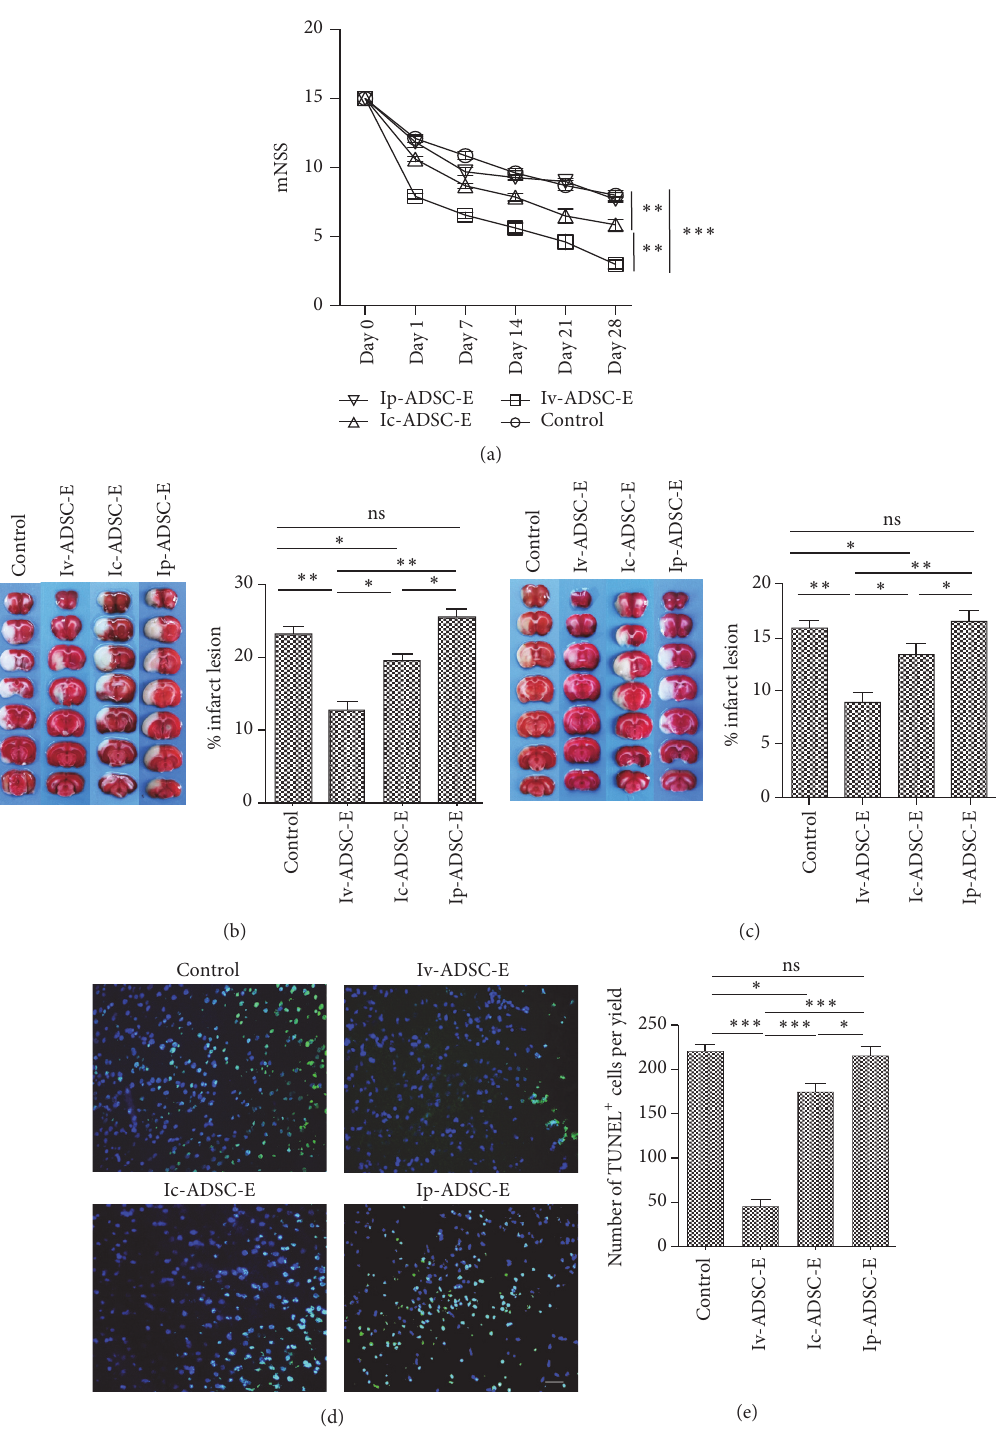
Figure 2: The impact of delivery routes on the therapeutic effect of ADSC-E during stroke. tMCAO was induced using SD rat. Protein extracts from ADSCs (ADSC-E) were injected either through IV, IC, or IP after the operation. (a) The neurological deficits were graded based on mNSS scaling system ( 𝑛 = 8 /group). (b, c) TTC staining was used to quantify the volume of infarct area at either Day 1 ( 𝑛 = 6 /group) (b) or Day 7 ( 𝑛 = 6 /group) (c). (d, e) TUNEL staining was used to measure apoptotic neurons. Scale bars: 100um (e). Five sections from each mouse were selected ( 𝑛 = 3 /group). For each section, TUNEL positive neural cells were counted from 3 separated yields. ANOVA was used to analyze the data. ∗ 𝑝 < 0.05 , ∗∗ 𝑝 < 0.01 , and ∗∗∗ 𝑝 < 0.001